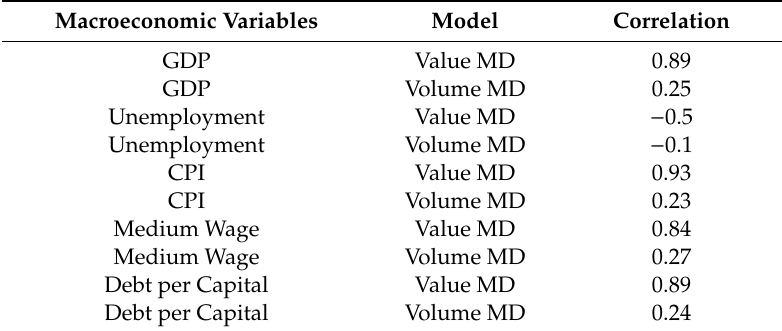
Table 2. Correlation of the model for